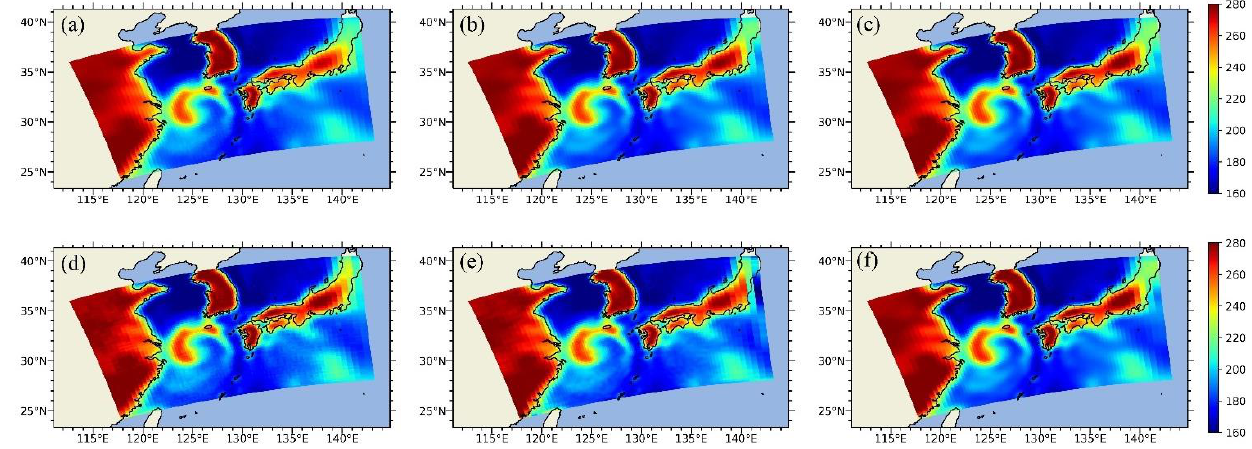
Figure 10. Comparisons of effects of RMSE magnitude on ATMS channel 2 resampling from three algorithms ( a – c ) resampled by BGI, AAPP, and modified AAPP, respectively with a low RMSE; ( d – f ) resampled by BGI, AAPP, and modified AAPP, respectively with a high RMSE. The unit of brightness temperature is K.